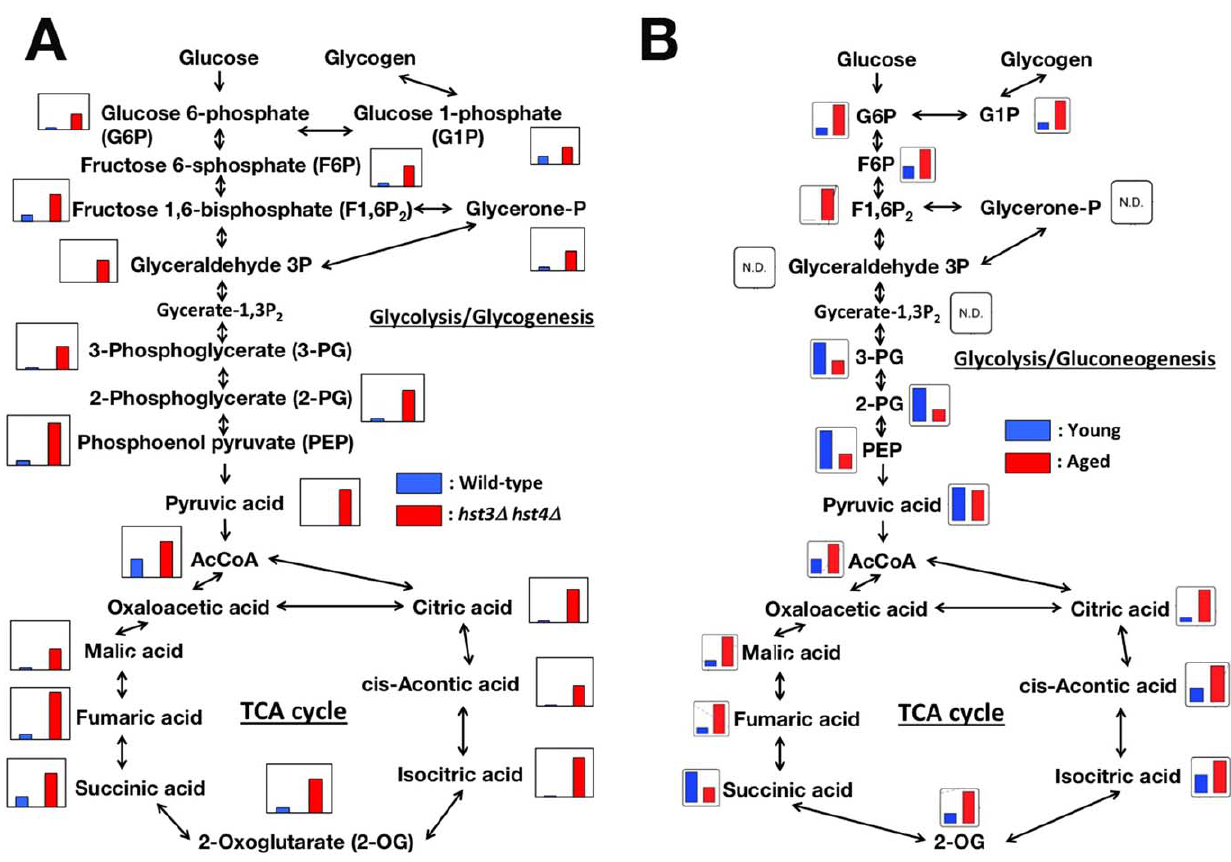
Figure 2. hst3 D hst4 D cells accumulate a number of metabolic intermediates from glucose metabolism in a pattern similar to that of aged cells. (A) The metabolic profiling data of glucose metabolites in wild type and hst3 D hst4 D cells were mapped onto known pathways. Each graph was derived from the calculated amount of metabolic intermediates shown in Table S1. The cells were cultured in SC medium at 30 u C for 3 days and analyzed by CE-TOFMS. (B) The metabolic profiling data of central carbon metabolism in both young and aged cells was mapped as in (A). Each graph was derived from the calculated amount of metabolic intermediates shown in Table S2.